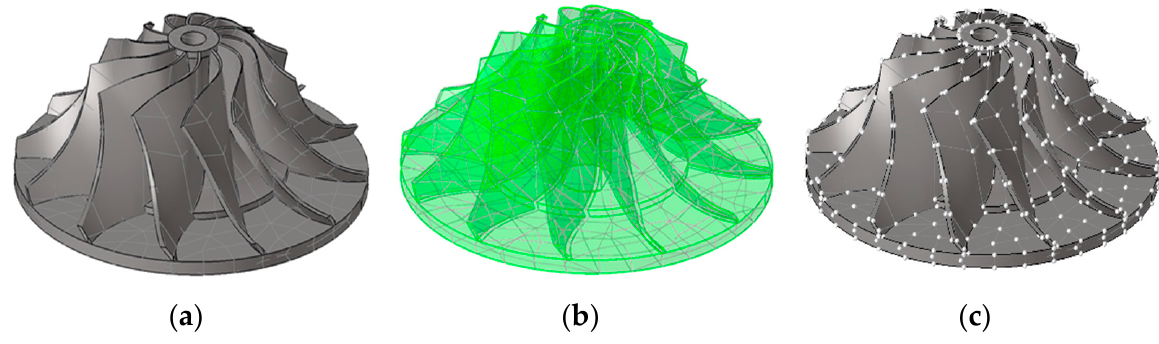
Figure 14. Sampling point acquisition for turbine model: ( a ) CAD model; ( b ) grid division; ( c ) sampling data points. Table 5. Fitting error results after removing the “noise” from the turbine model.